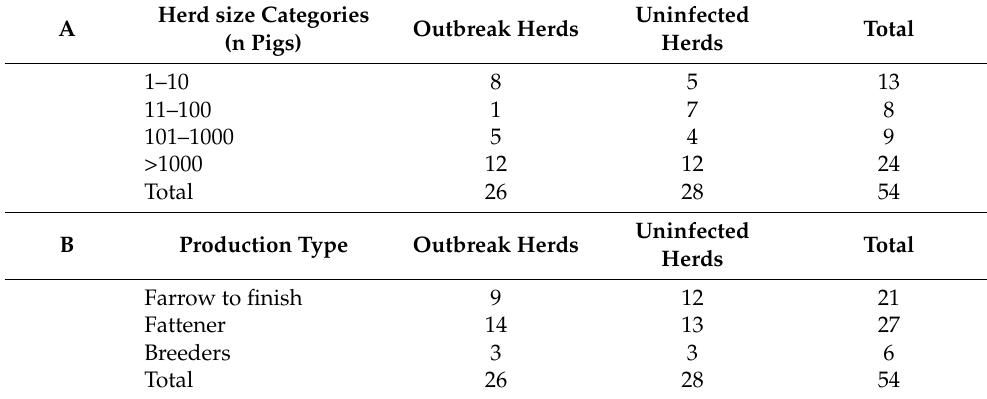
Table 2. Distribution of outbreak and uninfected herds between herd size categories ( A ) and produc- tion types ( B